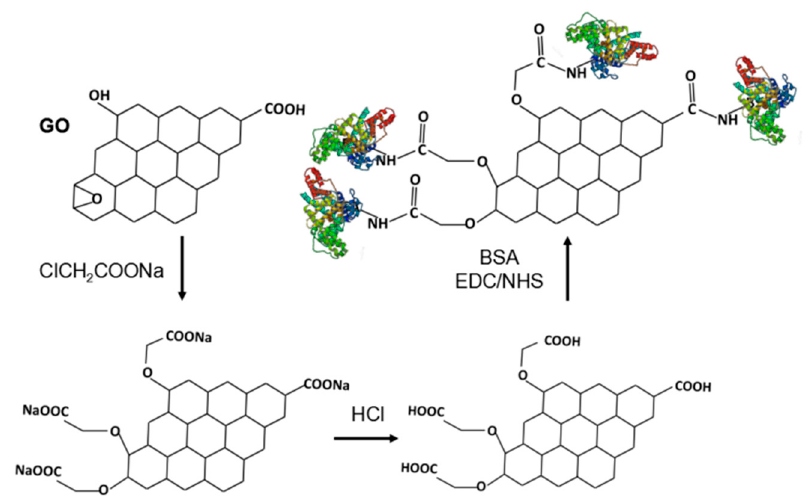
Figure 2. Schematic illustration of the functionalization of GO and the formation of GO–BSA nanohybrids by covalent interaction-mediated biomolecular self-assembly on GO surface.